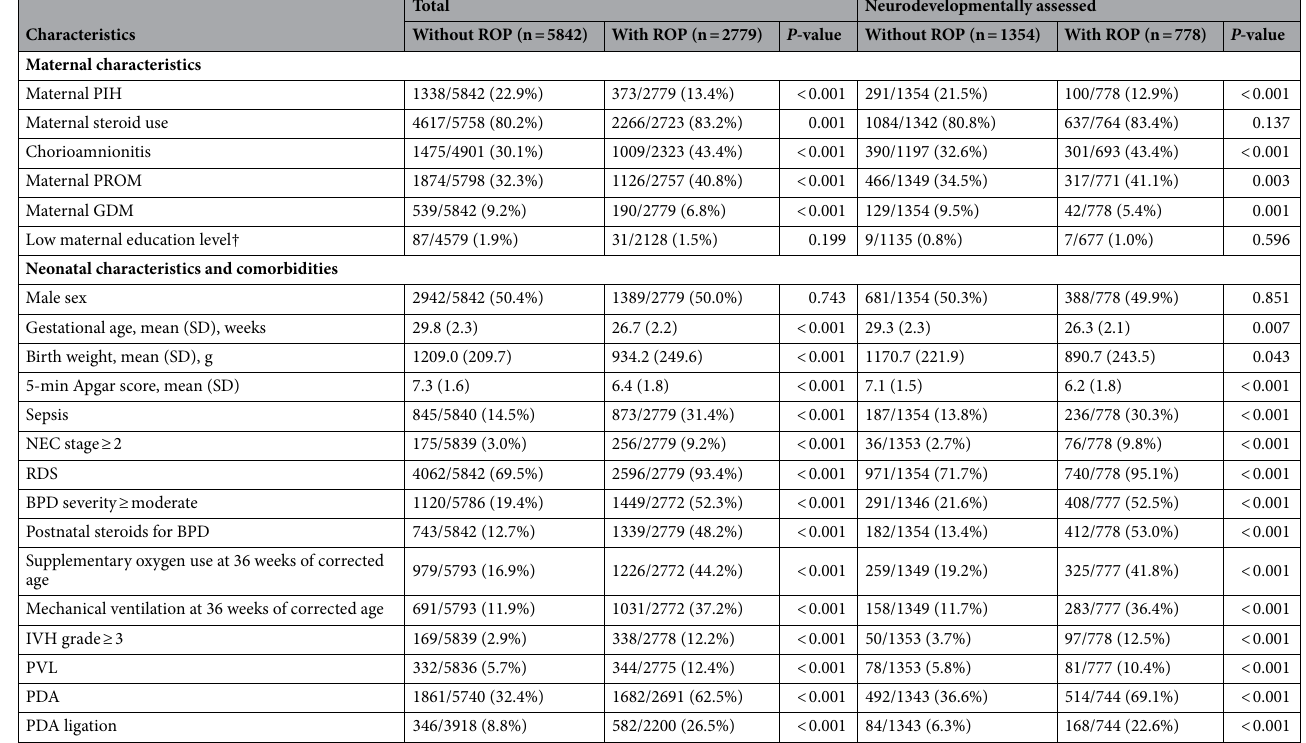
Table 1. Demographic characteristics of premature infants with and without retinopathy of prematurity. ROP retinopathy of prematurity, PIH pregnancy-induced hypertension, PROM premature rupture of membranes, GDM gestational diabetes mellitus, RDS respiratory distress syndrome, BPD bronchopulmonary dysplasia, NEC necrotizing enterocolitis, IVH intraventricular hemorrhage, PDA patent ductus arteriosus, PVL periventricular leukomalacia. *For categorical variables, the chi-squared test was used to compare the groups. For continuous variables, unpaired T-test was used to compare the groups. † Low maternal education level indicates less than high school.